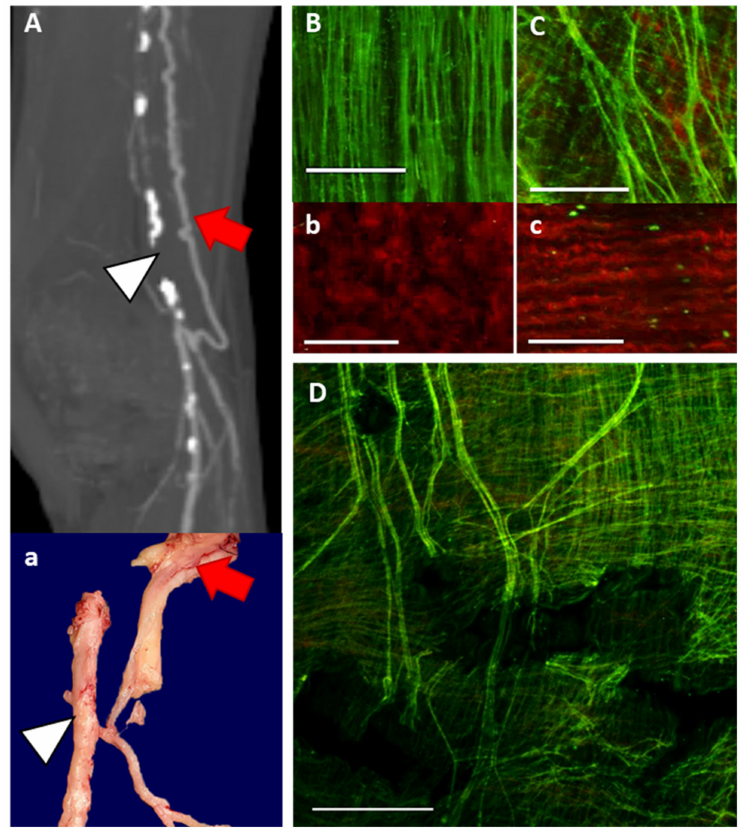
Figure 6. ECM characteristics of functional human collateral arteries. CT arteriography ( A ) and gross specimen ( a ) from patient undergoing trans-femoral amputation for lower limb ischemic gangrene. The occluded femoral-popliteal artery is indicated by white arrowhead, and the collateral artery is shown in red arrow. Notably, the collateral artery is embedded within the sciatic nerve. ( B , b ) Baseline elastic and collagen structure from arterial specimen that is not collateralized. ( C , c ) Elastic and collagen structure of human collateral artery taken from amputation specimen. Bar = 50 µ m. ( D ) Enlarged view of human collateral artery isolated near red arrow ( a ) demonstrating dispersed elastic fibers with numerous breaks, and gaps in elastic substructure. Bar= 100 µ m. Elastin appears green and collagen appears red. Images acquired with Olympus FV1000MPE utilizing 830 nm